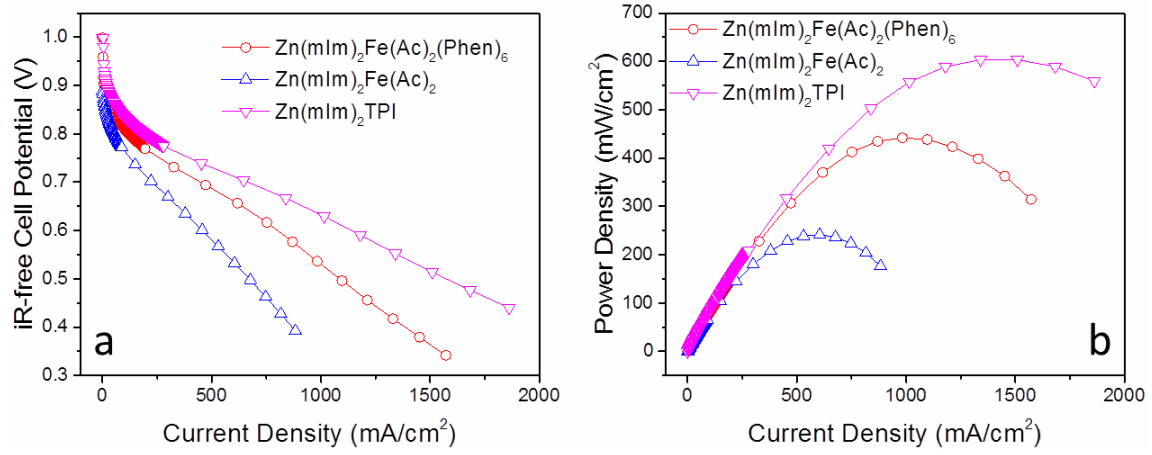
Figure 1. ( a ) Polarization curves from different iron additive electrocatalysts. The current densities at 0.8 V iR-free for Zn(mIm) 2 Fe(Ac) 2 = 64.7 mA cm − 2 , Zn(mIm) 2 Fe(Ac) 2 (Phen) 6 = 136.9 mA cm − 2 , and Zn(mIm) 2 TPI = 221.9 mA cm − 2 . ( b ) Power density curves corresponding to polarization curves shown in ( a ). Maximum power density for Zn(mIm) 2 Fe(Ac) 2 = 241.5 mW cm − 2 , Zn(mIm) 2 Fe(Ac) 2 (Phen) 6 = 441.9 mW cm − 2 , and Zn(mIm) 2 TPI = 603.3 mW cm − 2 . Conditions: (back pressure = 7.3 psig) fully humidified; T = 80 °C; N211 membrane; 5 cm 2 MEA; cathode catalyst = 3.5–4 mg/cm 2 , anode catalyst = 0.4 mg Pt /cm 2